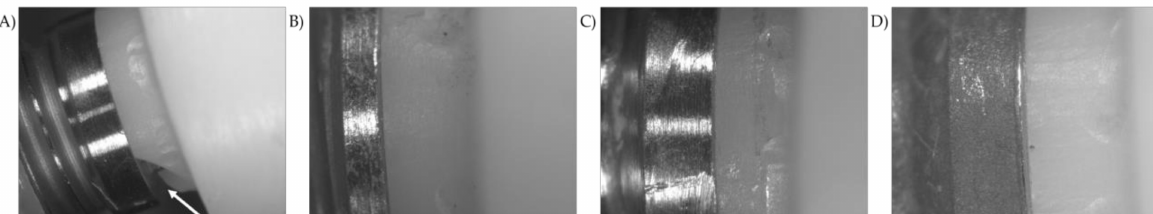
Figure 2. Marginal assessment after 2.5 × 10 6 cycles (40 × ) of the interface between implants and zirconia crowns. Arrow: zirconia fracture G1 ( A ), G2 ( B ), G3 ( C ) and G4 ( D ).